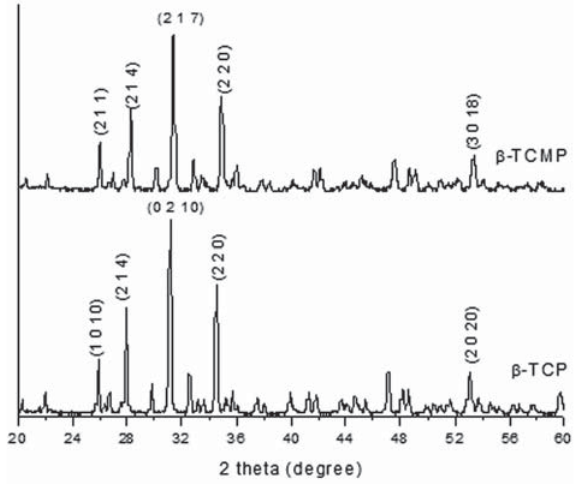
Figure 3- FTIR spectra of tricalcium phosphate ( β -TCP) and magnesium-substituted β -TCP heat-treated at 1000°C in air for 4